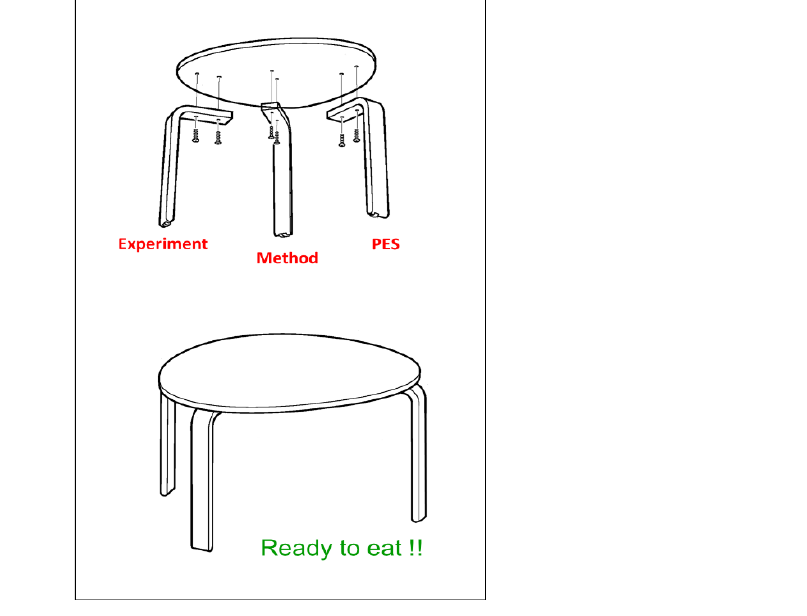
Figure 1. Theory/experiment comparison. The analogy of the table with three legs.